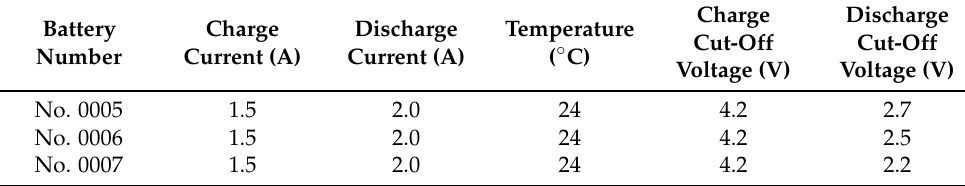
Table 5. Partial test procedure of the NASA